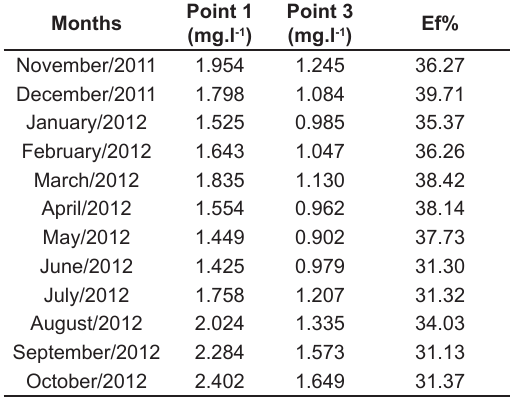
Table 4. Efficiency retention of total nitrogen in 1 and 3.